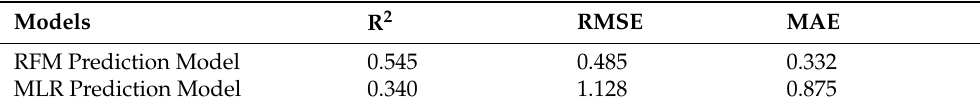
Table 4. Comparison of the model prediction accuracies. The RMSE and MAE indicate the root mean squared error and mean absolute error. The RFM and MLR indicate the random forest model and multiple linear regression model, respectively.